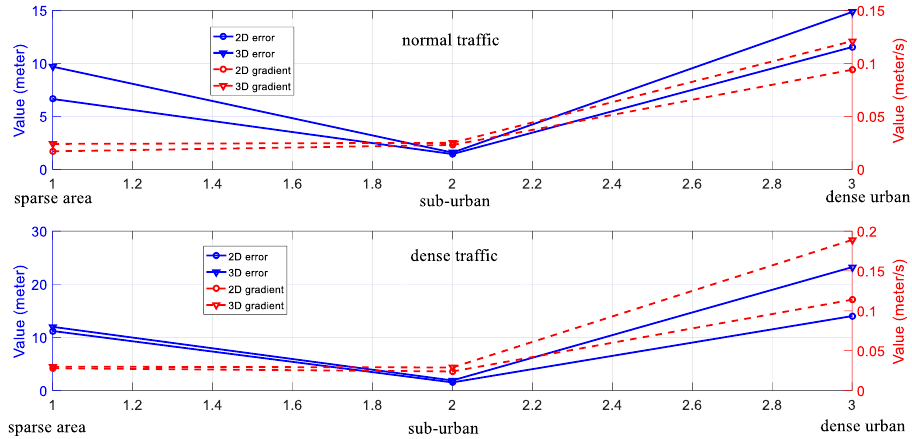
Figure 15. The relationship between the degree of urbanization and the performance of LiDAR-based positioning. The x-axis indicates the degree of urbanization. The y-axis on the left side represents the value of positioning error and the y-axis on the right side indicates the positioning error gradient.